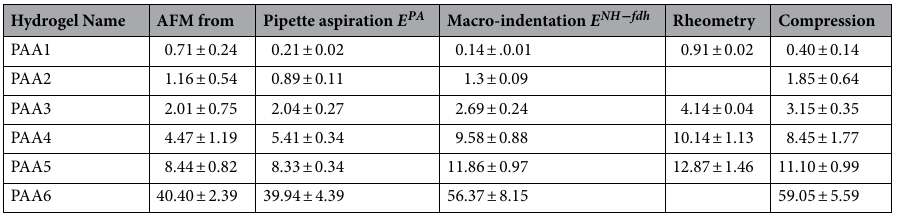
Table 4. Comparison of PAA Hydrogel elastic modulus measured with different techniques. For static macroindentation data of E NH-fhd are taken from Table 1. Data for micropipette aspiration EPA are calculated for a minimum of 10 measurements made on the same gel and ΔE represents the standard deviation.